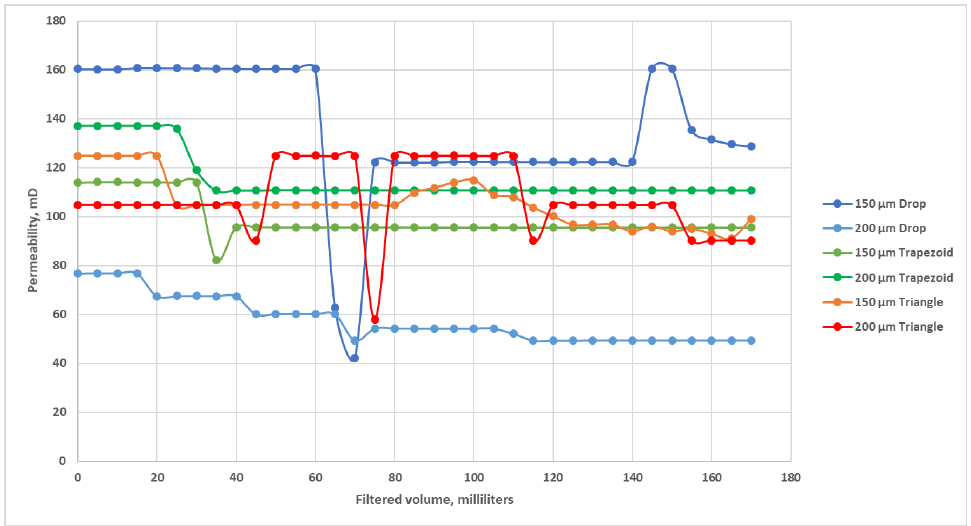
Figure 8. Retained permeability of screens in millidarcies.